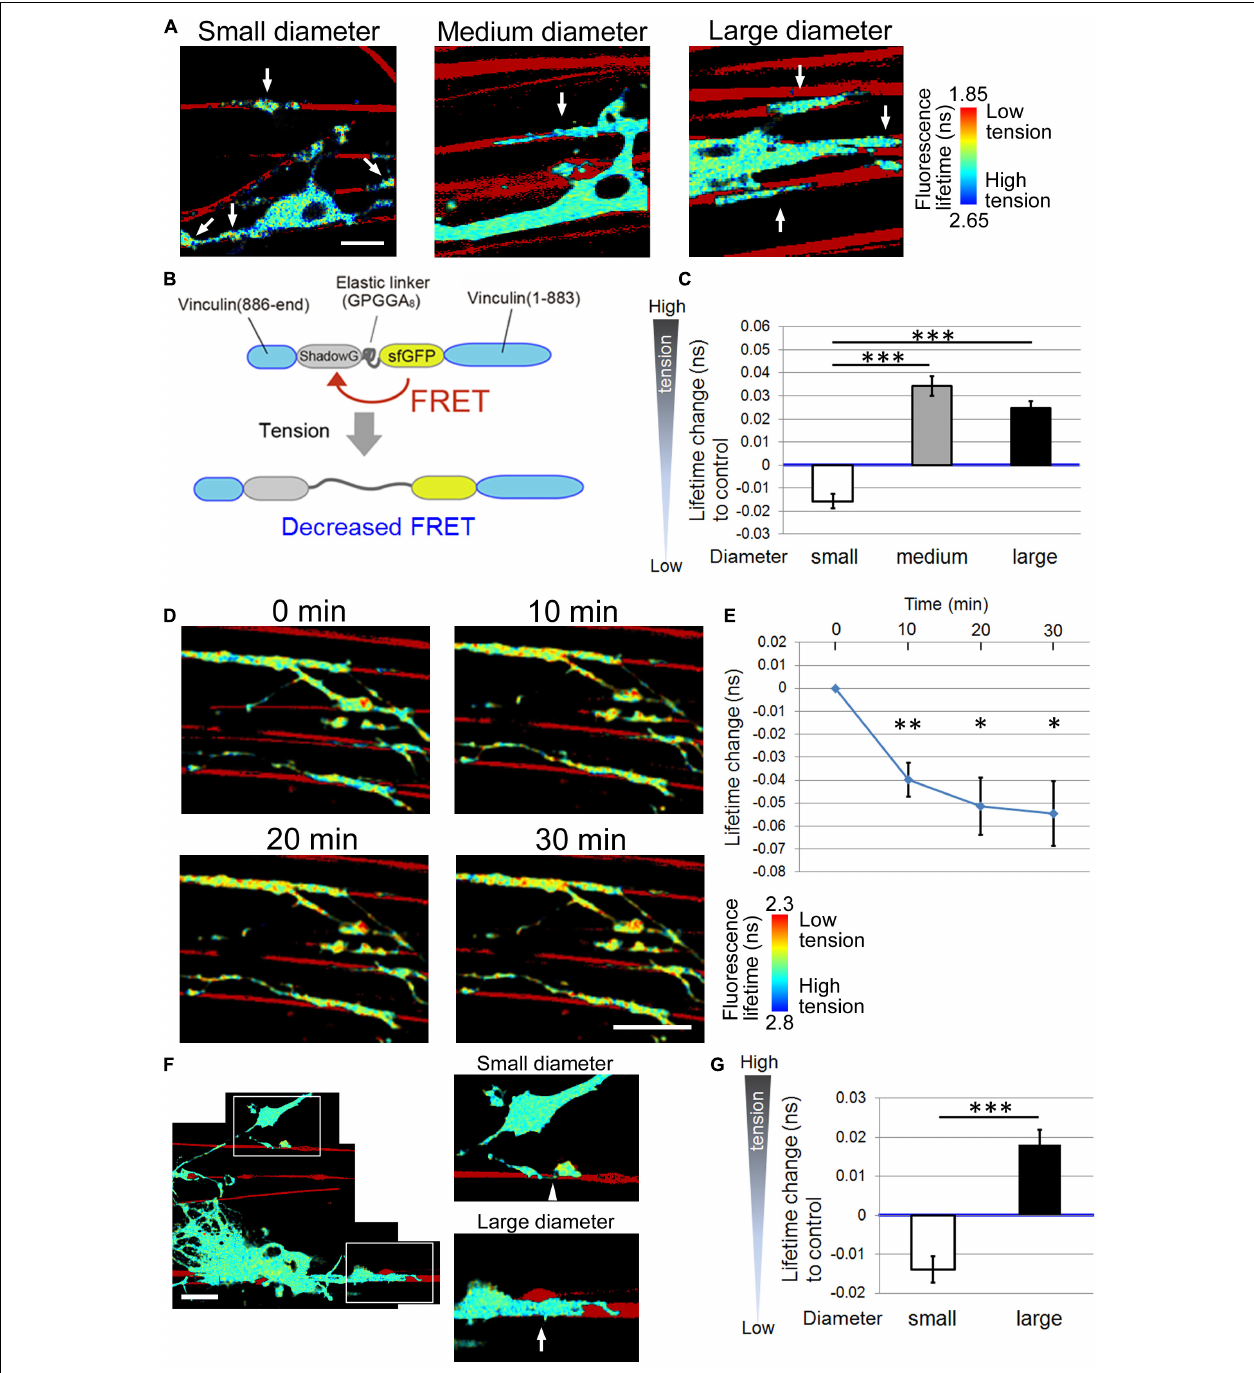
FIGURE 3 | Higher tension is generated at OL processes contacting larger diameter fibers. (A) Representative fluorescence lifetime images of the tension sensor-expressing OL contacting nanofibers with different diameters. Sulforhodamine (red) shows polystyrene nanofibers. Arrows indicate the fluorescence lifetime images on nanofibers. Scale bar, 10 µ m. (B) A schematic drawing of a conformational change in the elastic domain of the tension sensor. The efficiency of FRET decreases when a mechanical force is applied on it, setting the two fluorophores apart from each other. (C) Quantification of average fluorescence lifetime changes relative to the control value in OLs contacting small-diameter (0.55–0.9 µ m), medium-diameter (1.5–1.7 µ m) and large-diameter (2.5–4.0 µ m) nanofibers ( ∗∗∗ P < 0.001 by one-way ANOVA with a Tukey’s post hoc test; n = 58 areas analyzed per condition, from five independently prepared cultures established on different days). (D) Fluorescence lifetime images of tension sensor-expressing OLs treated with cytochalasin D (1 µ M). The images show OL processes before and after (10, 20, and 30 min) cytochalasin D treatment. Sulforhodamine (red) shows polystyrene nanofibers. Cytochalasin D application to OLs significantly